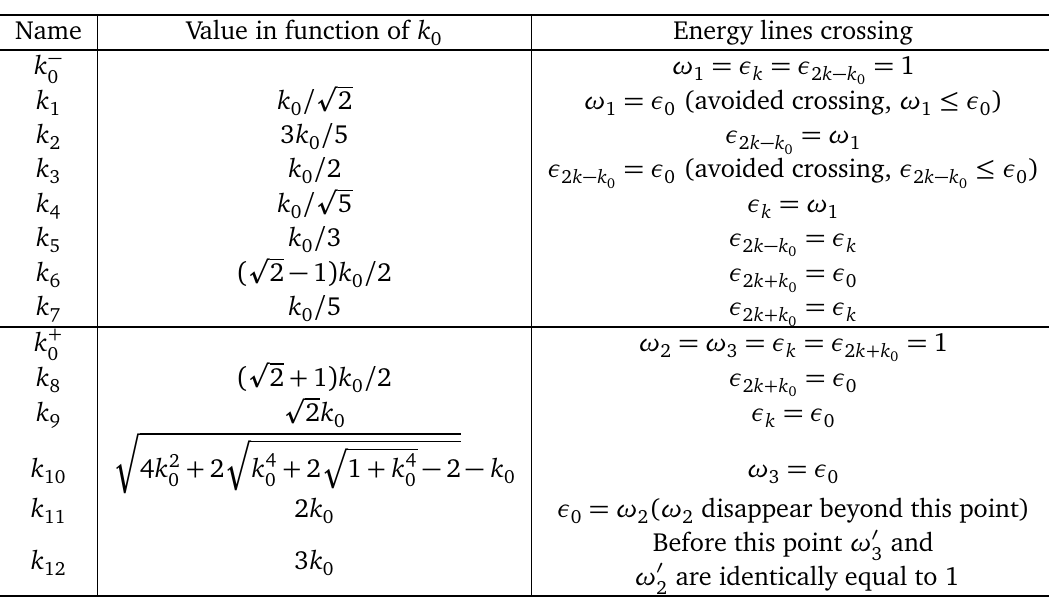
Table 7: Values of k where energy lines